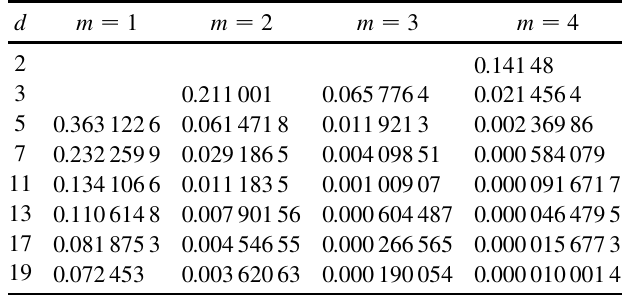
TABLE II. The distillation threshold (cid:4) (cid:7) for depolarizing dep ð m Þ . We include the threshold noise when distilled by QRM d for the Brayvi-Kitaev protocol using 15 qubits, which uses a ð 4 Þ . Empty cells indicate quantum Reed-Muller code QRM 2 that no non-Clifford gates exist for those